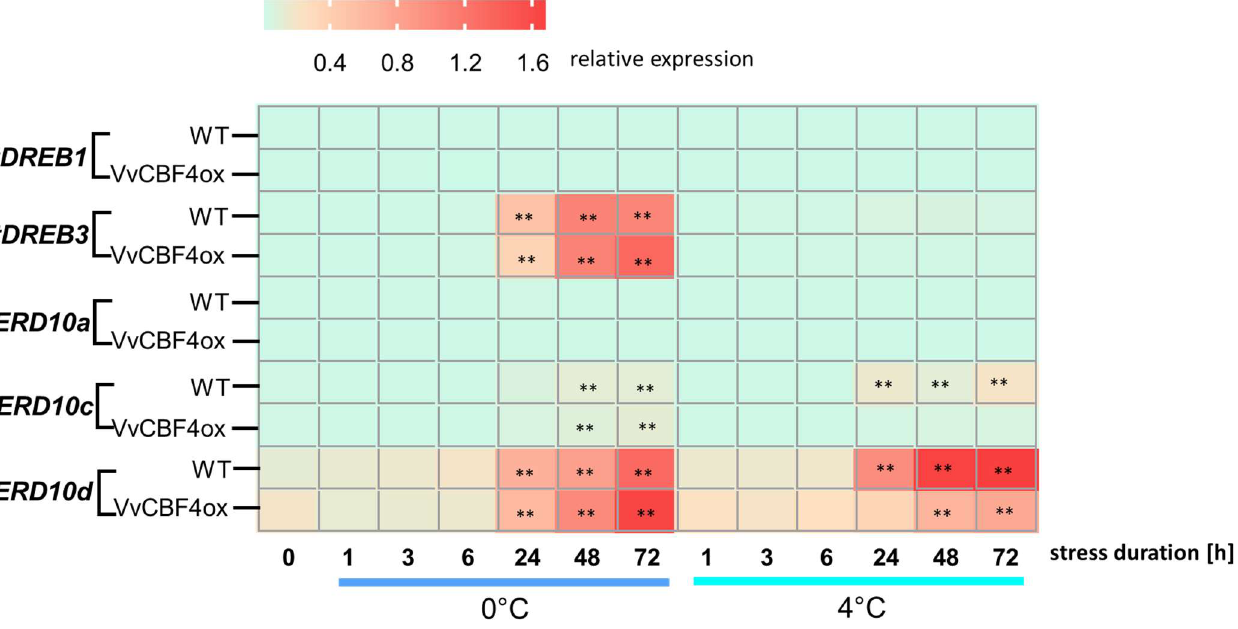
Figure 4. Time course of the relative expression of endogenous CBF genes and COR genes in response to chilling (4 ◦ C) and freezing (0 ◦ C). Colour code shows steady-state levels for two endogenous CBF ( NtDEB1 and NtDEB3 ) and three COR transcripts ( NtERD10a , NtERD10c , and NtERD10d ) relative to L25, based on 2 − ∆ Ct . Data represent means from three independent experimental series, each in technical triplicates. Asterisks (**) represent statistically significant differences in the LSD test ( p < 0.01).